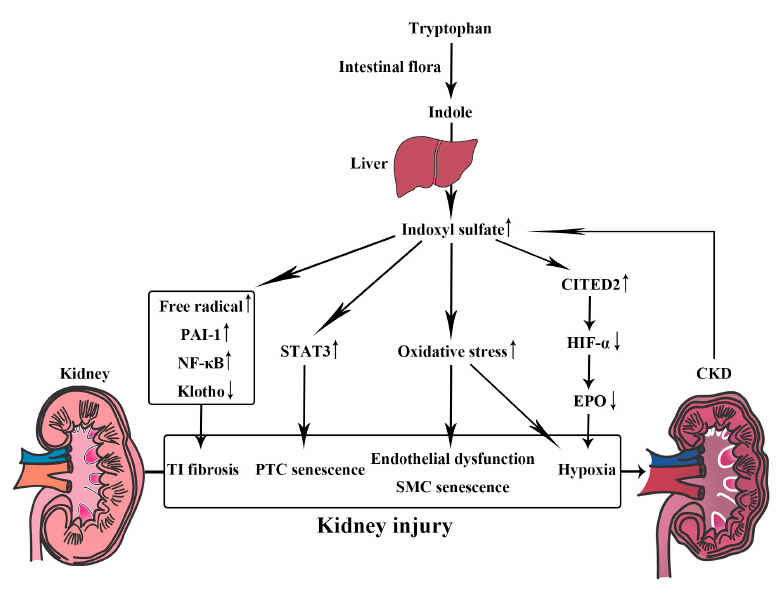
Figure 2. Pathogenic effects of indoxyl sulfate as a uremic toxin. Indoxyl sulfate induces renal tubulointerstitial (TI) fibrosis, renal proximal tubular cell (PTC) senescence, vascular endothelial dysfunction, vascular smooth muscle cell (SMC) senescence, and chronic renal hypoxia, all of which lead to CKD progression. PAI-1; plasminogen activator inhibitor-1, NF- κ B; nuclear factor-kappa B, STAT3; signal transducer and activator of transcription 3, CITED2; Cbp/p300-interacting transactivator with Glu/Asp-rich carboxy-terminal domain 2, HIF- α ; hypoxia-inducible factor- α , EPO; erythropoietin.